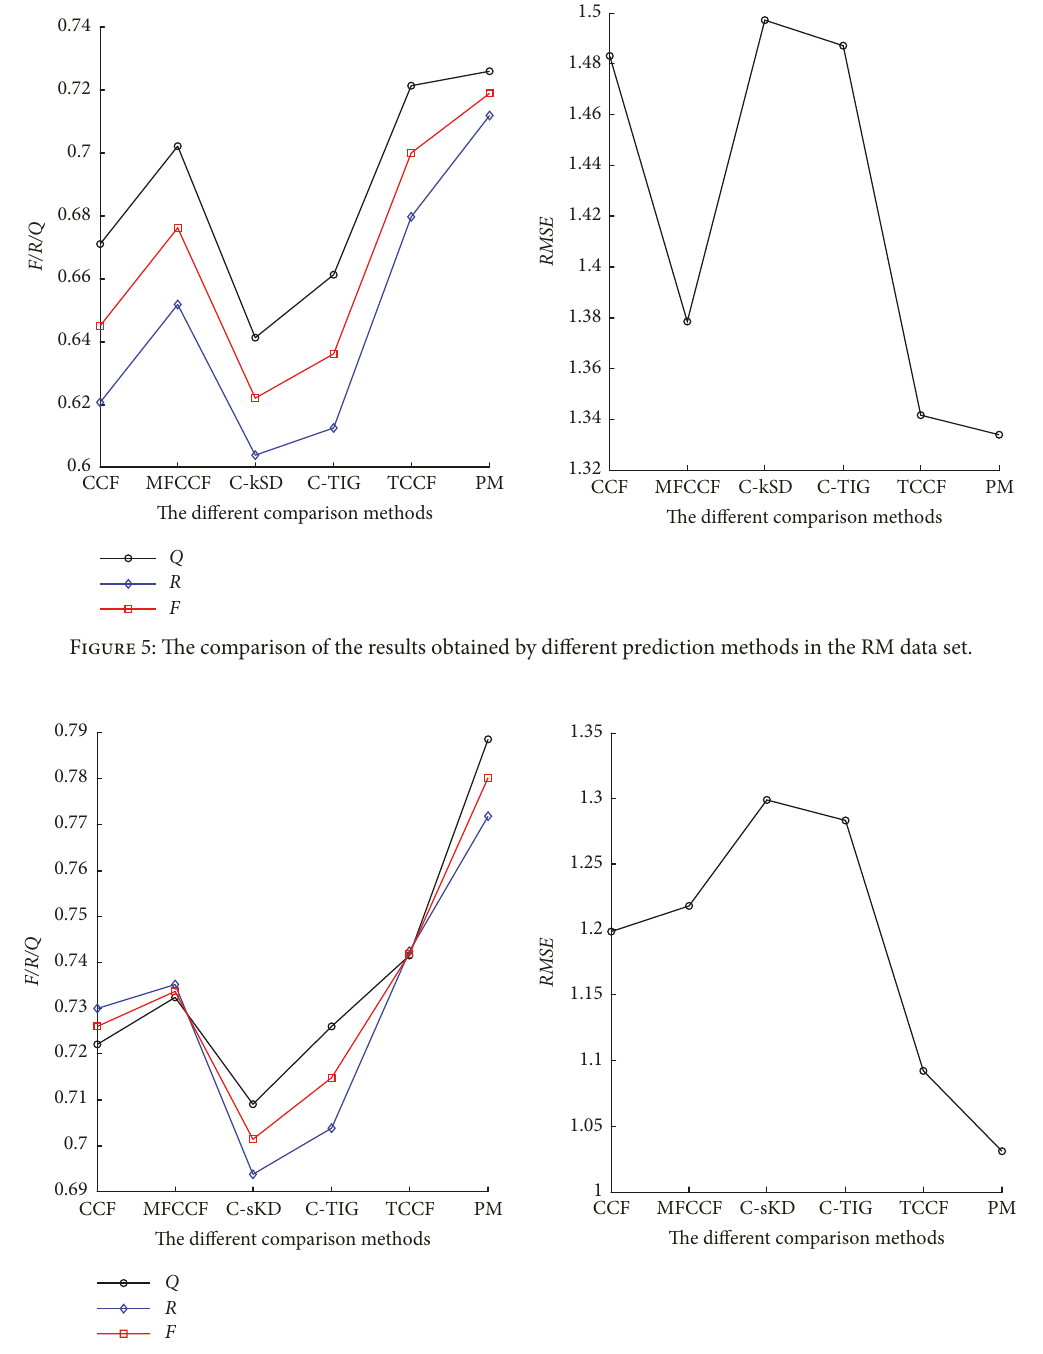
A The results obtained by the C-kSD are the